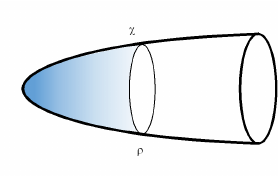
Figure 1 . A string worldsheet wraps the cigar from the tip to some radial distance ρ